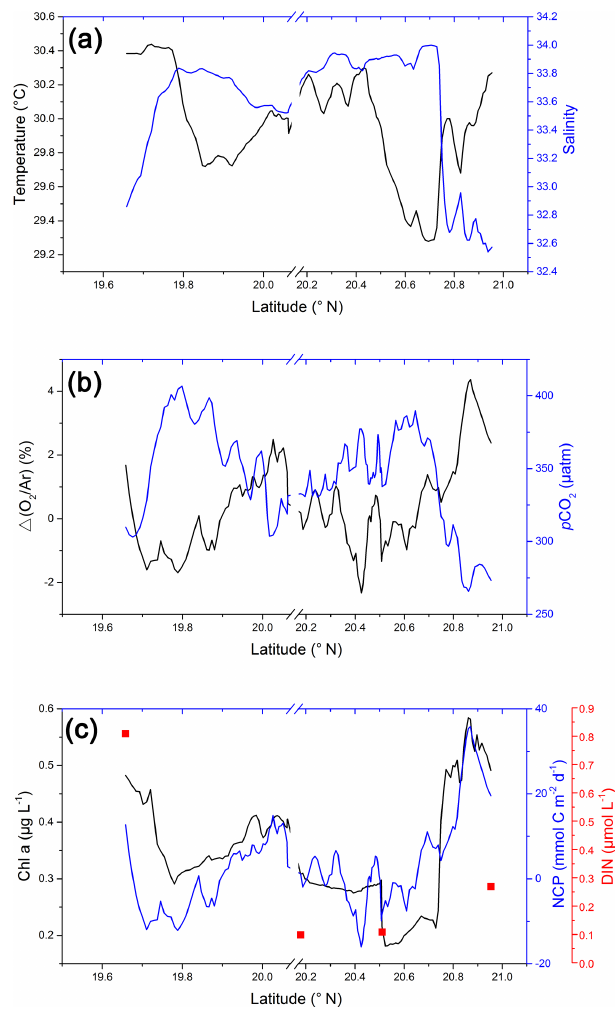
Figure 6. Meridional variations in (a) temperature, salinity, (b) (cid:49) (O 2 / Ar), p CO 2 , (c) Chl a , NCP, and the surface concentra- tion of DIN along Transect 4 in June 2015. The plots of (cid:49) (O 2 / Ar), p CO 2 , and NCP are 10-point Savitzky–Golay